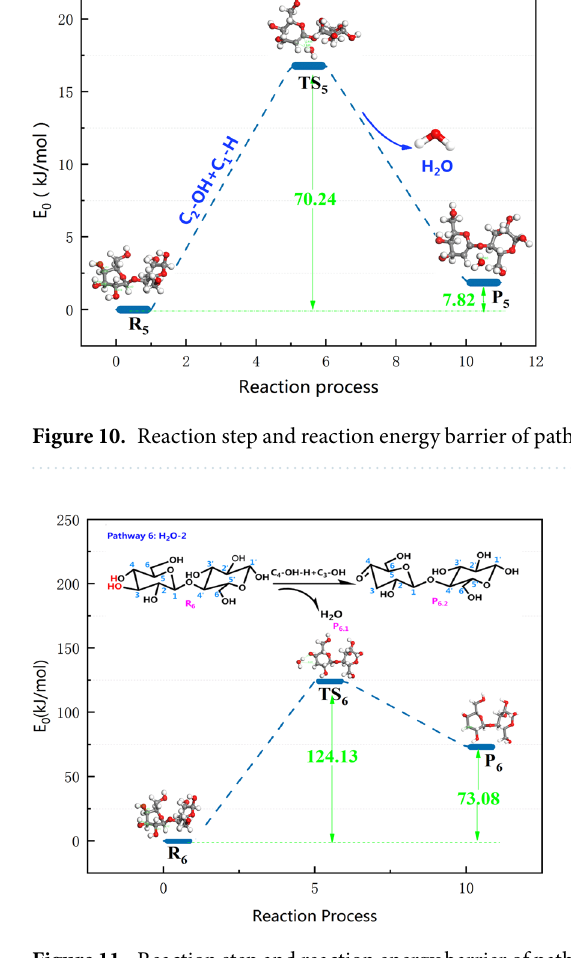
Figure 11. Reaction step and reaction energy barrier of pathway 6.